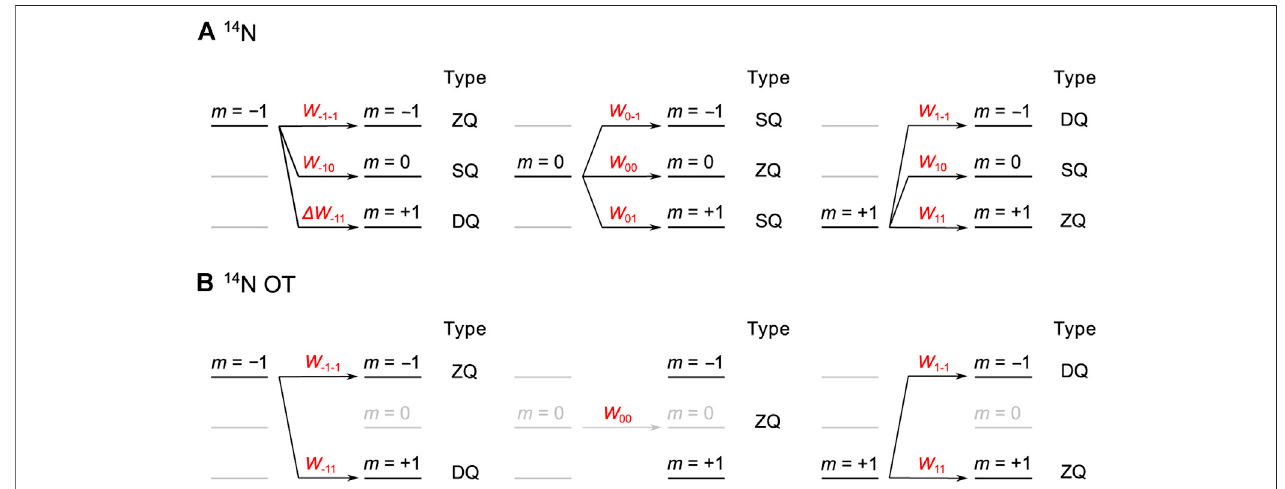
Δ m (cid:1) 0), SQ(| Δ m | (cid:1) 1), andDQ (| Δ m | (cid:1) 2)transitionsof (A) 14 Nand (B) 14 NOTtoderive the ij ) forZQ (